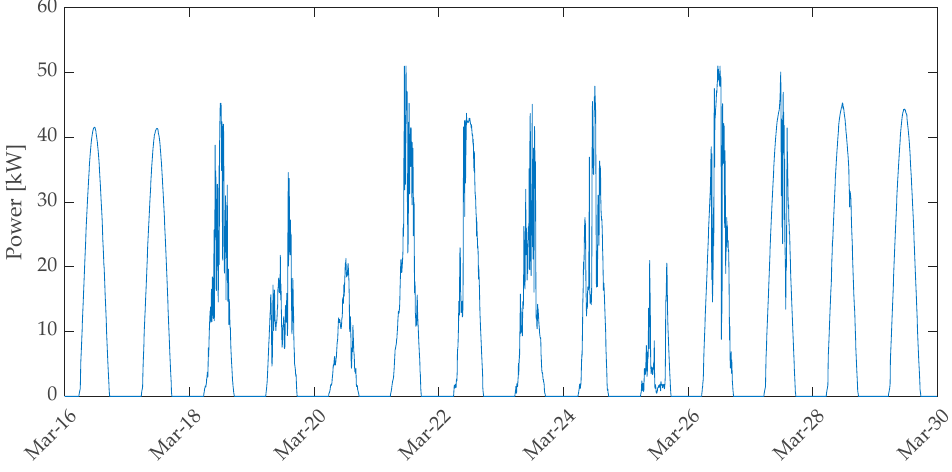
Figure 3. Loads: Accommodation and electric vehicle.